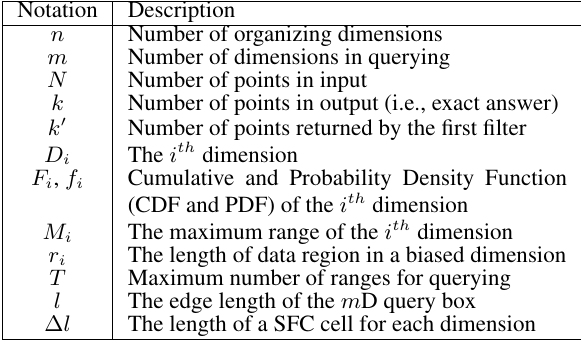
Table 2. Notations used in the